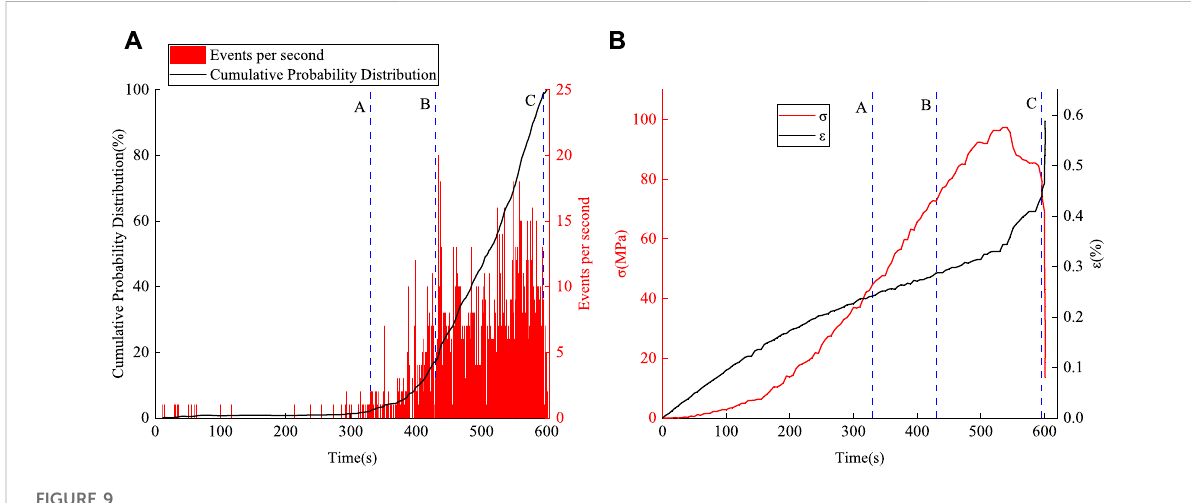
FIGURE 9 Results obtained for specimen G2: (A) CPD of the feature events and (B) variation of the stress and strain in the specimen during the same period.